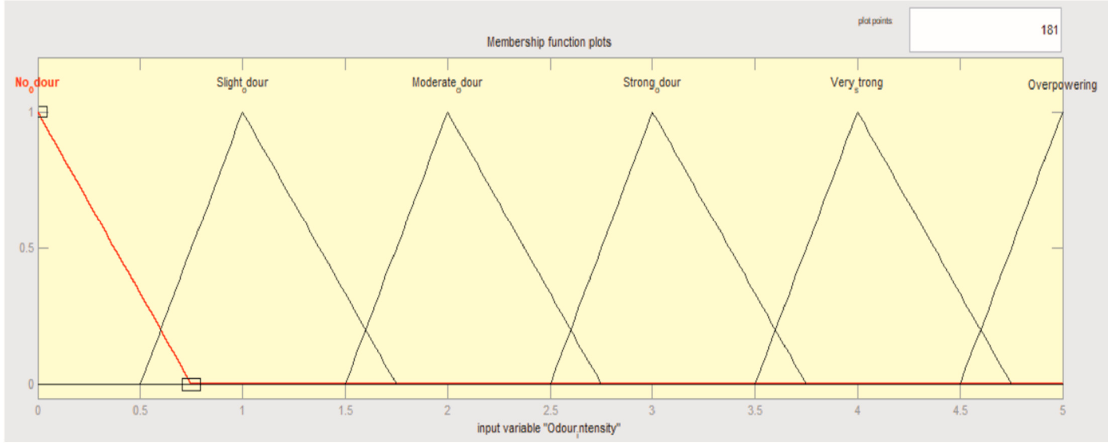
Figure 2. Membership functions of odor intensity.